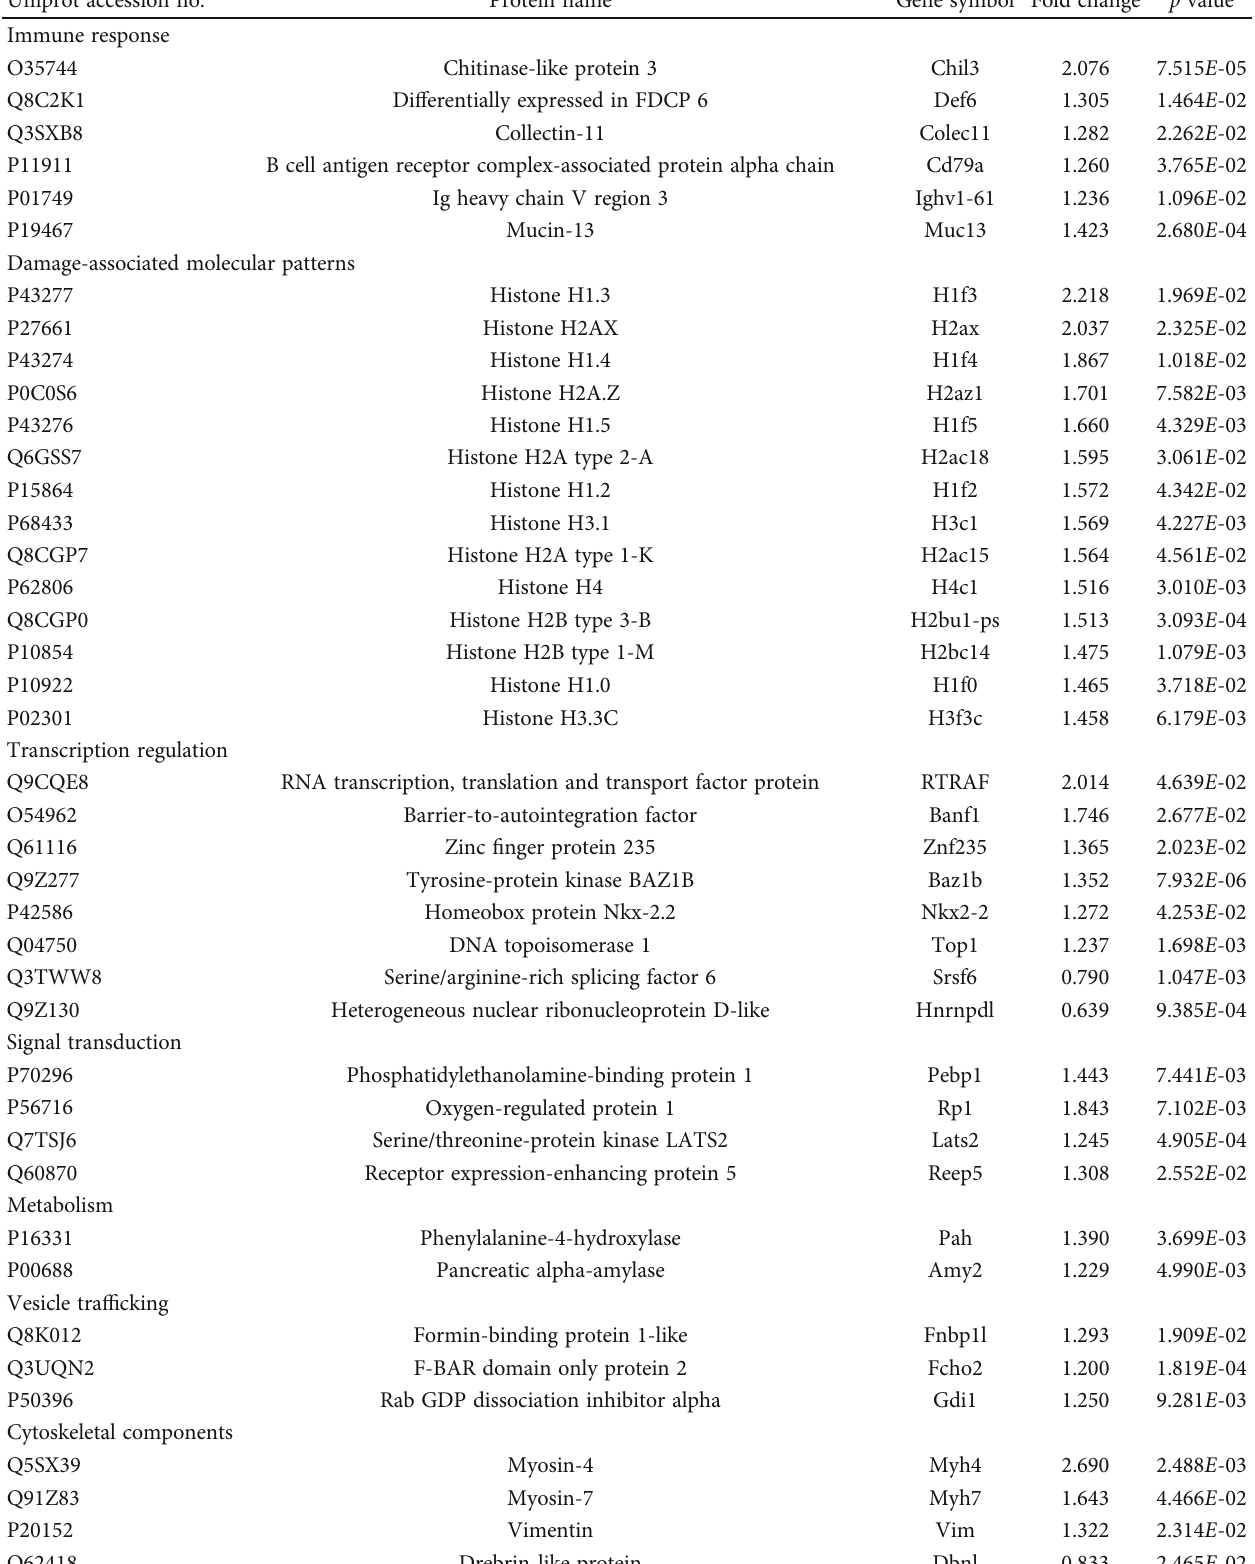
Table 2: Di ff erentially expressed proteins in B cell exosomes in response to Pneumocystis infection. Uniprot accession